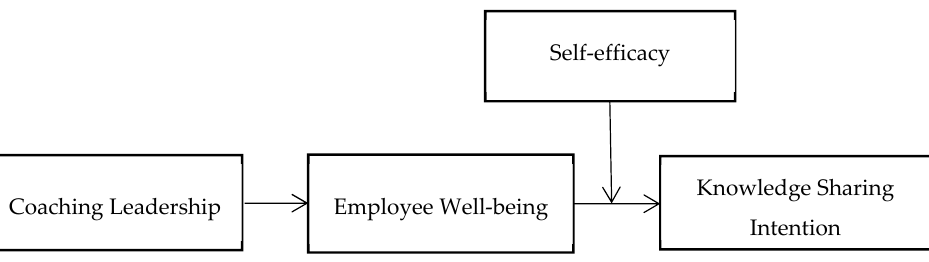
Figure 1. Hypothesized research model.